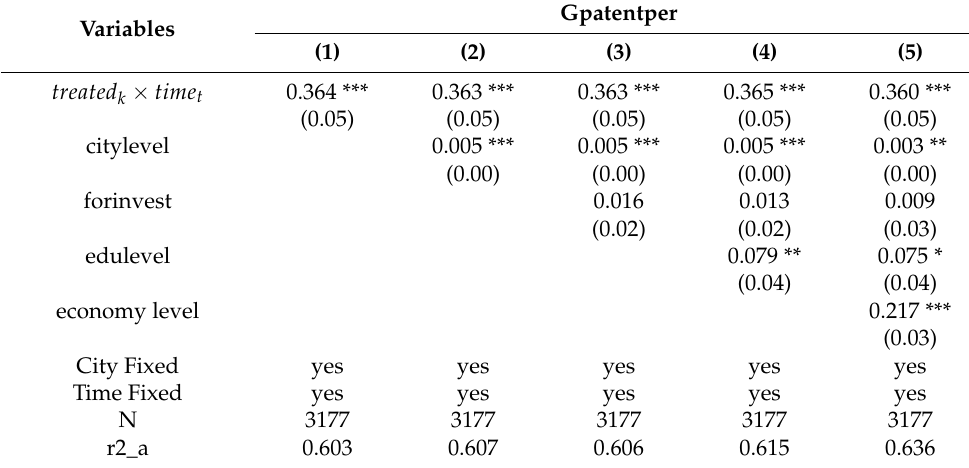
Table 2. Baseline regression results.